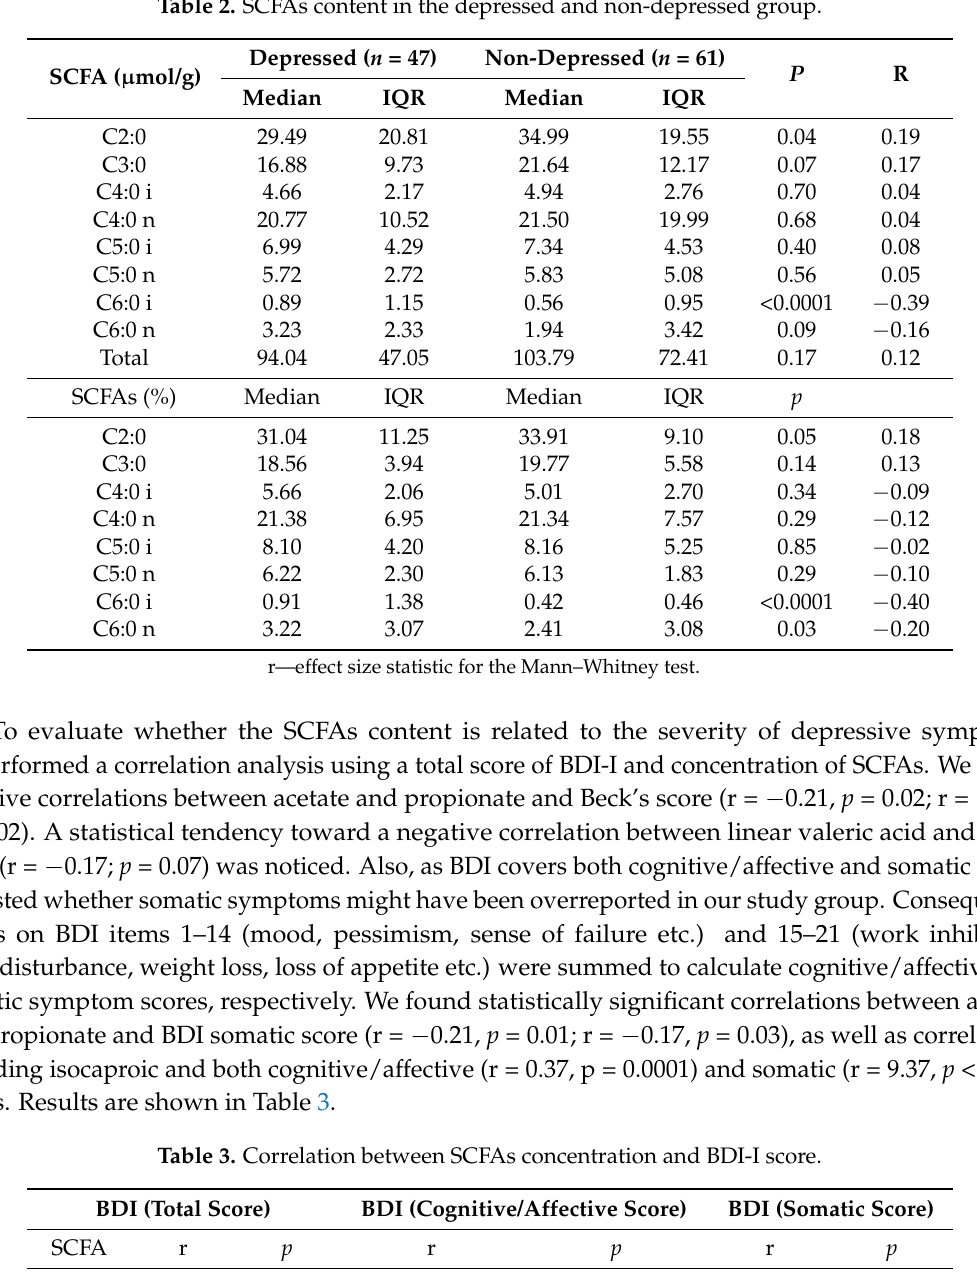
Table 2. SCFAs content in the depressed and non-depressed group.